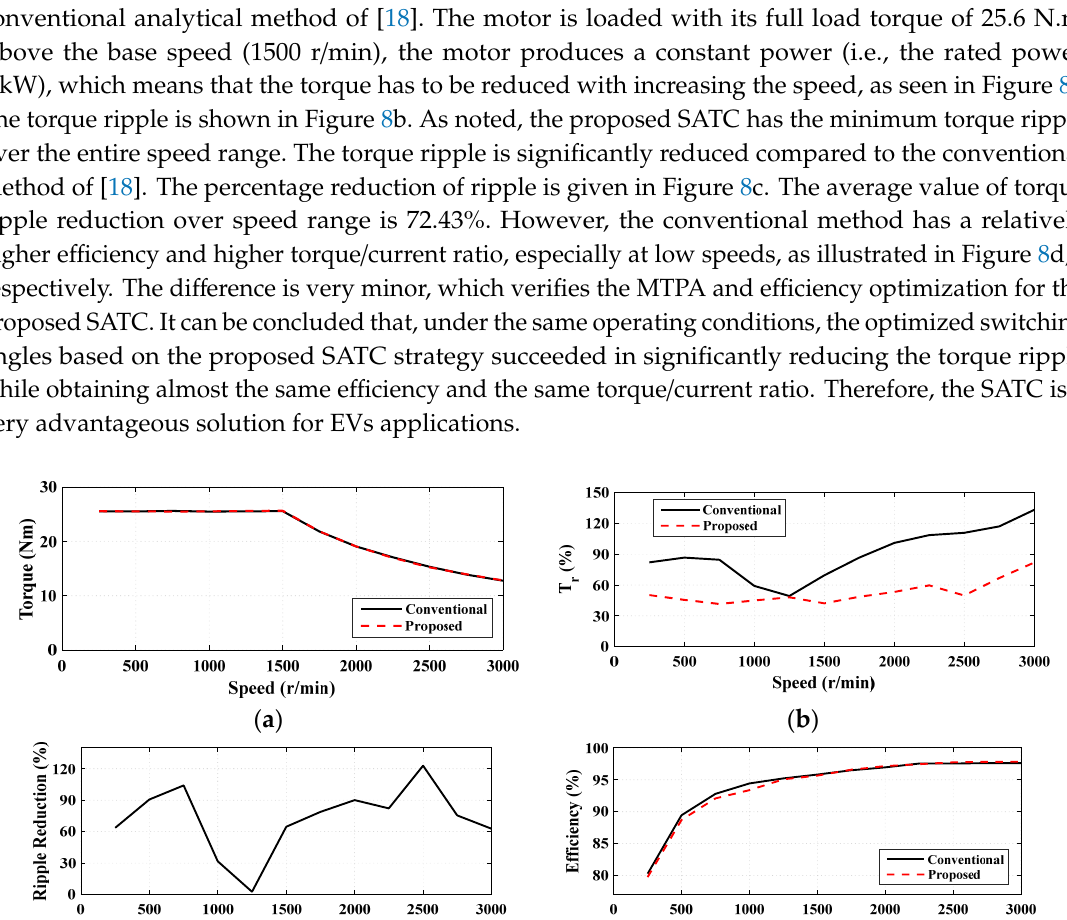
( b ) Figure 9. The steady-state torque curves at: ( a ) low speed (500 r/min); ( b ) high speed (2500 r/min). 4.2. The Dynamic Performance The dynamic performance for the proposed SATC strategy is investigated compared to the dynamic performance of the DATC of Figure 1b. The reason for choosing DATC is that it has a very good dynamic torque performance, as it uses a closed-loop torque control scheme. Note that the optimum solution of switching angles is used for both techniques (SATC and DATC). Hence, the torque ripple and efficiency will be almost the same under a steady state. The difference appears under dynamic conditions. 4.2.1. Sudden Change in Reference Speed and Load Torque Figure 10 shows the simulation results under a sudden change in reference speed and load torque. The reference speed is changed from 1500 to 2500 r/min at 1.0 sec. The load torque is suddenly changed from 17 to 13 N.m at 0.7 sec. Both the SATC and DATC can properly track the reference commanded speed, as shown in Figure 10a. As noted, the SATC has a better tracking